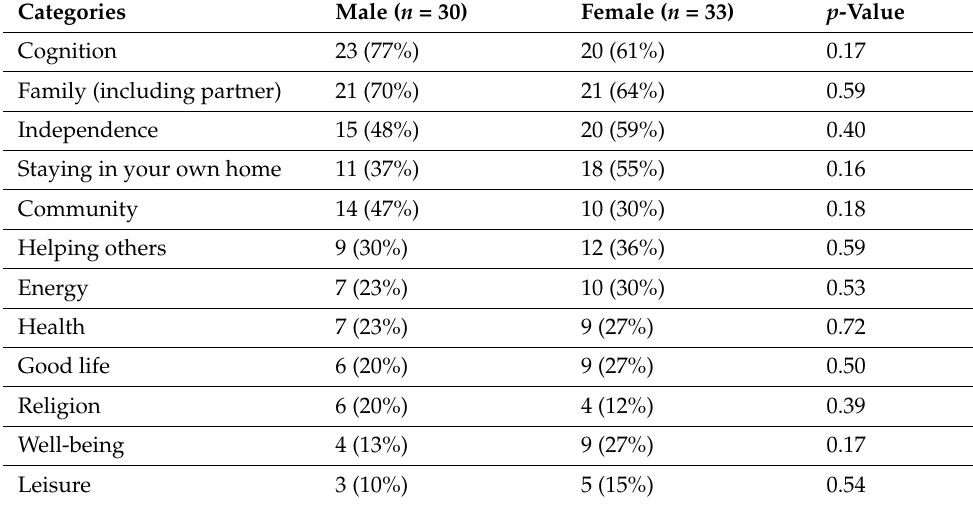
Table 4. Gender differences in category